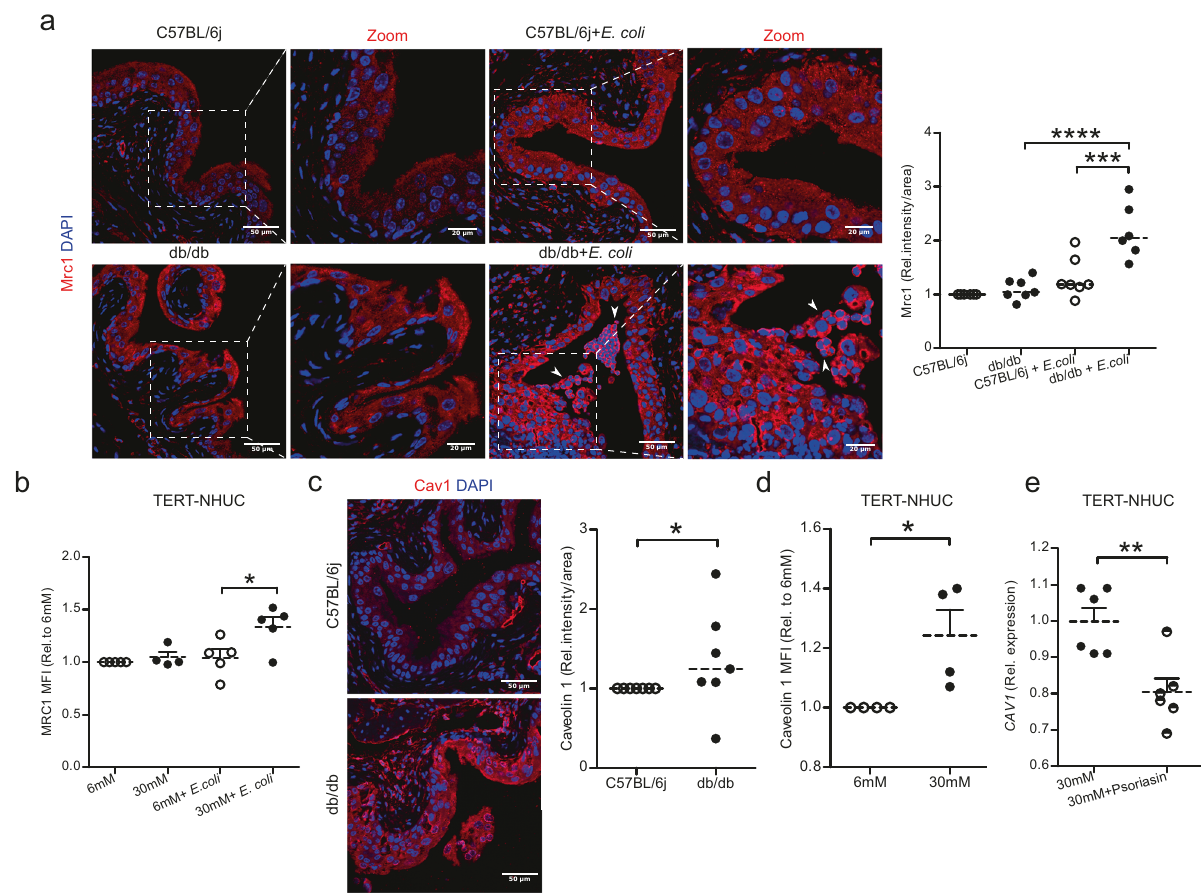
Fig. 4 | In fl uence of high glucose and E. coli infection on MRC1 and caveolin 1. a Mrc1 expression in urinary bladders from PBS treated and 24h E. coli infected diabetic, db/db ( n =7 and 6 respectively), and non-diabetic, C57BL/6j mice ( n =6 and 7 respectively). Zoomed images of selected representative areas (right panel) (One-way ANOVA, multiple comparison test, p ≤ 0.001 and p ≤ 0.0001). b MRC1 levels(mean fl uorescence intensity,MFI, fl owcytometry)TERT-NHUCuroepithelial cells treated with glucose (normal=6mM: high=30mM) for 36h, followed by 2h infection with MOI 10, (6mM, n =5; 30mM, n =4; 6mM+ E. coli , n =5; 30mM+ E. coli , n =5) (One-way ANOVA, multiple comparison test, p ≤ 0.05). c Urinary bladdersectionsofPBStreated,db/db,andC57BL/6jmice( n =7each)werestained